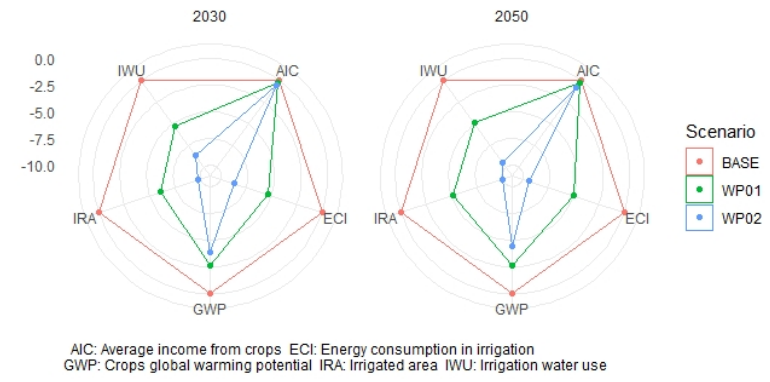
Figure 8. Synergies and trade-off analysis between nexus indicators. Source: own elaboration.